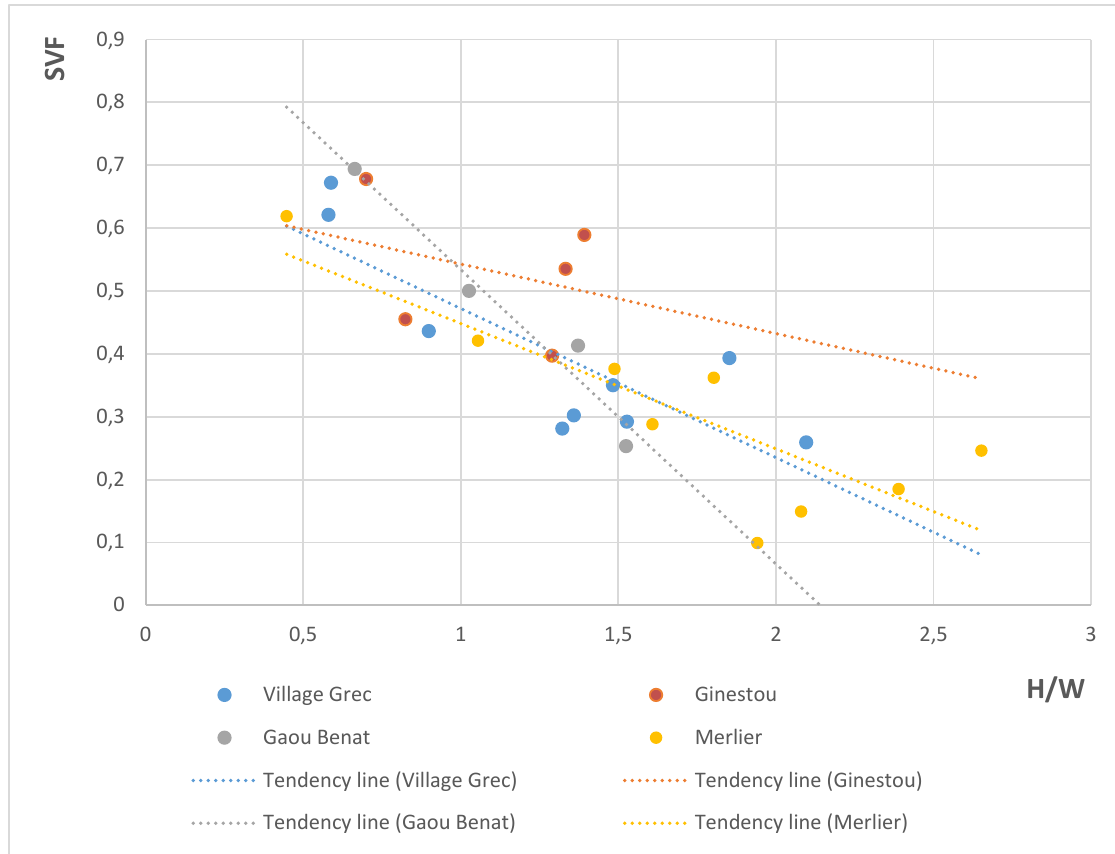
Figure 6. SVF to H/W for the four case studies with a tendency line per case study. Gaou Benat’s covered passage is not considered in the graph, since it is a very small passage and has a huge impact on the tendency